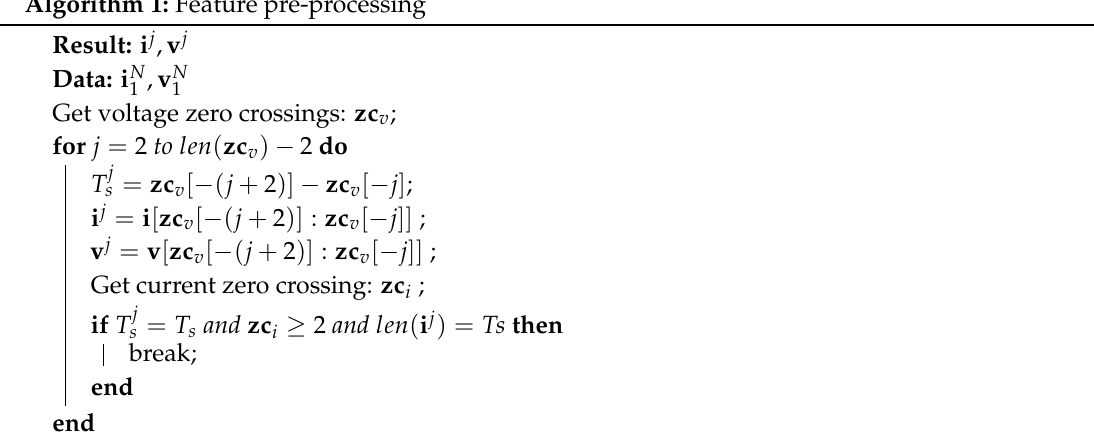
Algorithm 1: Feature pre-processing